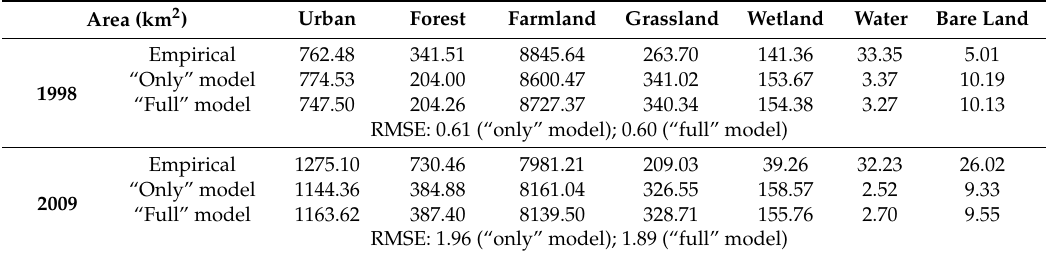
Figure 7. The comparison between the classified map and the predicted maps. Note: Predicted maps A were predicted with the incorporation of other drivers and predicted maps B were predicted with “only” the Markov-CA model. Table 6. The comparison between the empirical maps and simulated results from two